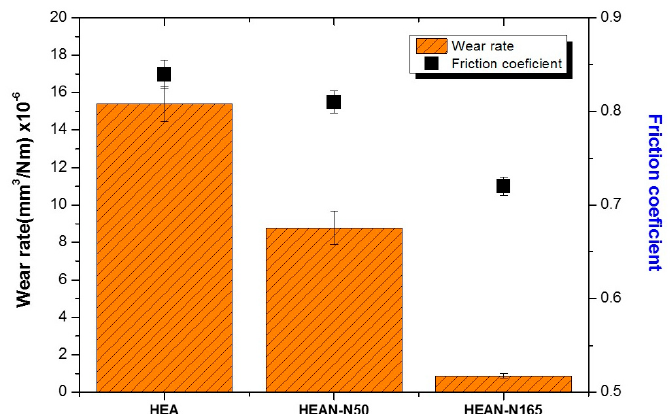
Figure 6. Wear rate and friction coefficient of the CrVTiNbZr(N) coatings (HEA, HEAN ‐ N50 and HEAN ‐ N165).